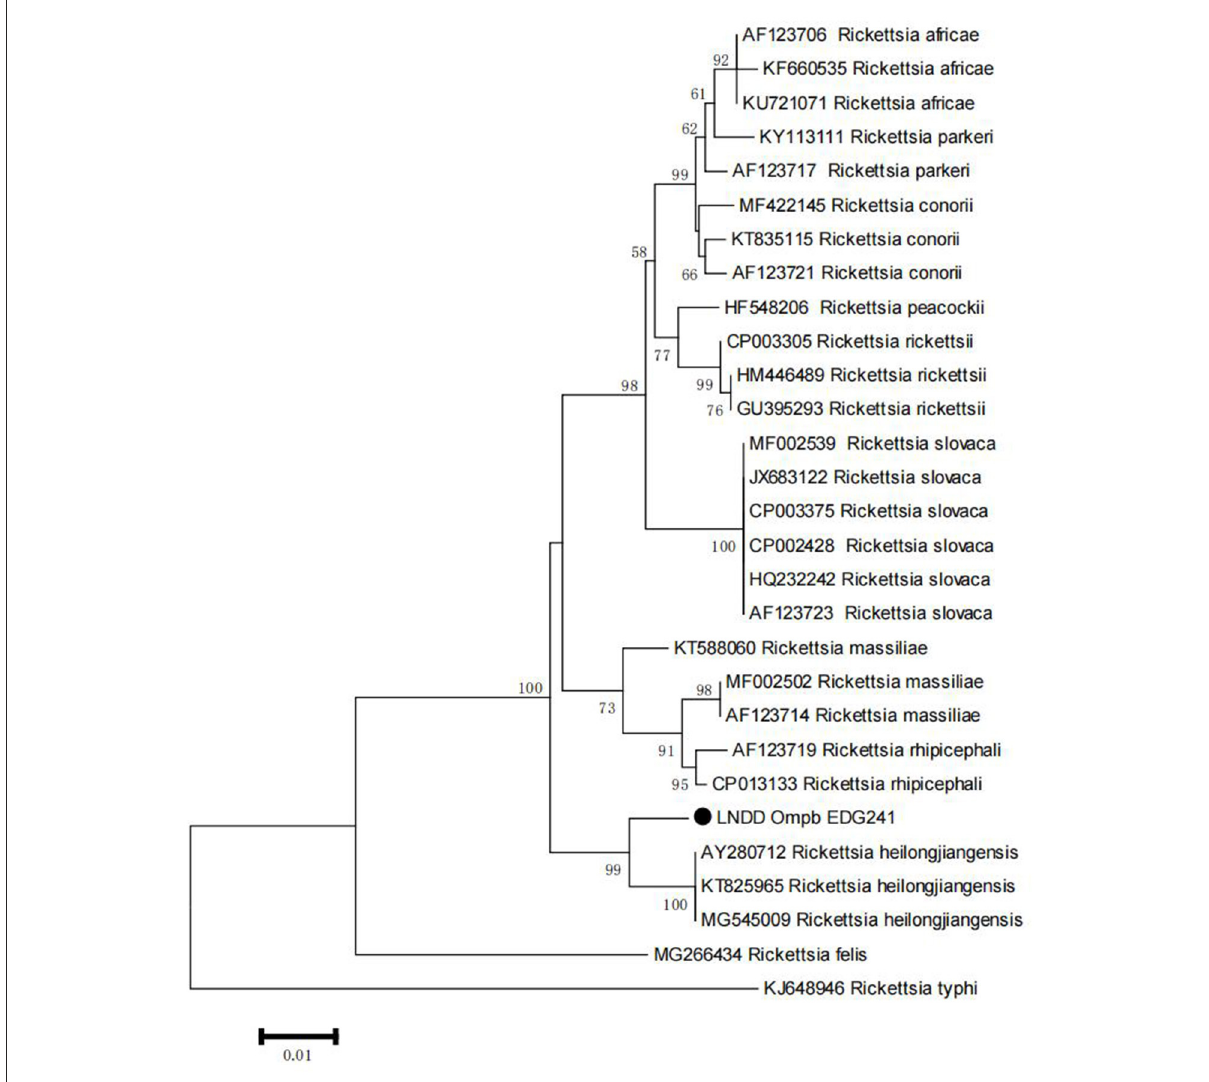
FIGURE4 Phylogenetic tree of Rickttsia with ompB amplified from PEA products. The trees were constructed with sequence of ompB using maximum-likelihood (ML) algorithms implemented in the Molecular Evolutionary Genetics Analysis (MEGA) 7 software. Black dot represents sequence acquired from this